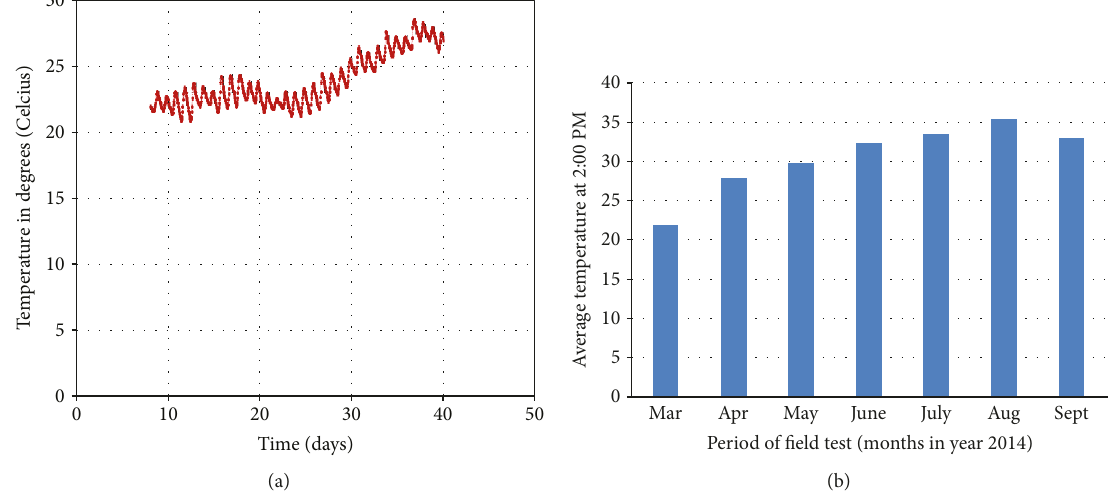
Figure 6: (a) 30-day temperature pro fi le and (b) average temperature pro fi le.